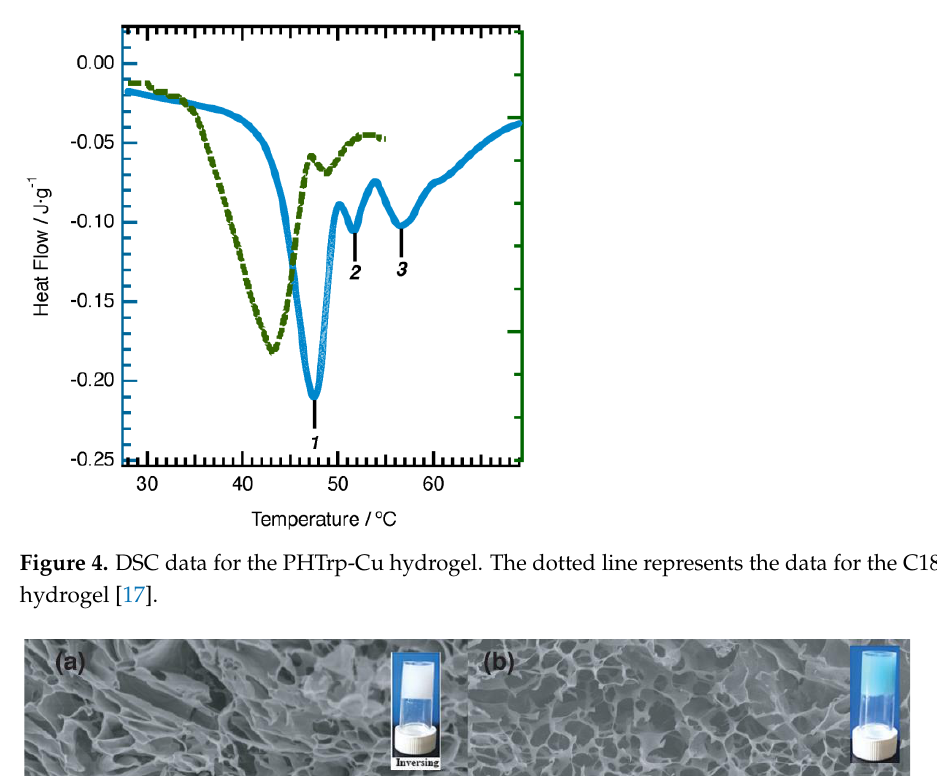
Figure 4. DSC data for the PHTrp-Cu hydrogel. The dotted line represents the data for the C18ADPA hydrogel [17].